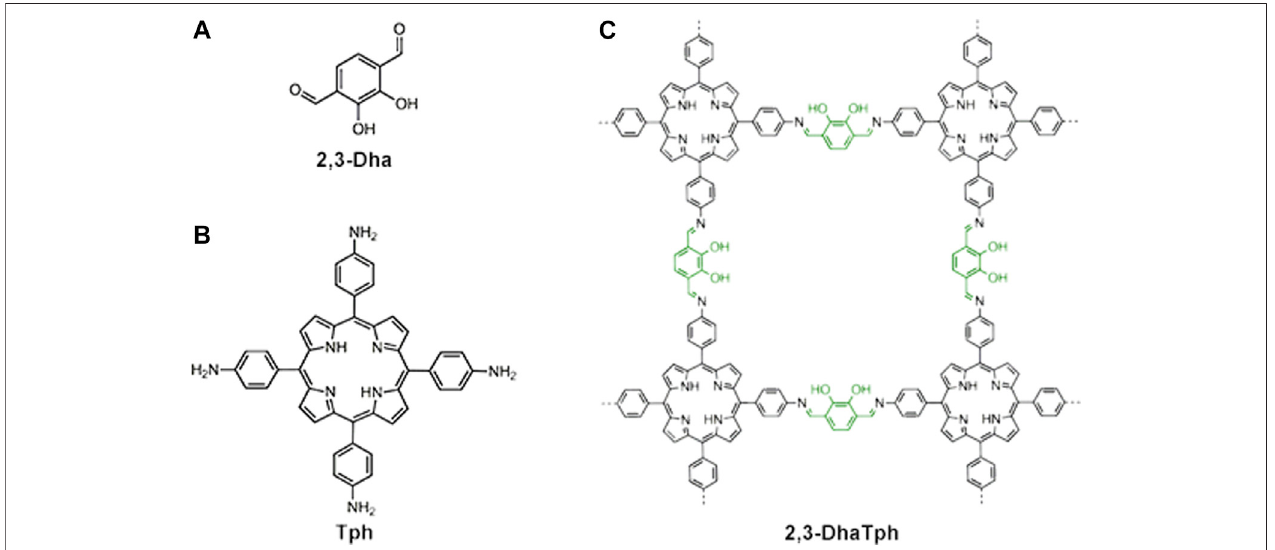
FIGURE 4 | The chemical structures of 2,3-Dha (A) , Tph (B) , and 2,3-DhaTph (C) . The hydroxy groups (green) act as acidic sites, whereas porphyrin and imine bonds (black) act as basic sites for an acid-base catalyzed cascade reaction. Adapted from Shinde et al. (2015) with permission. Copyright 2015 the Royal Society of Chemistry.